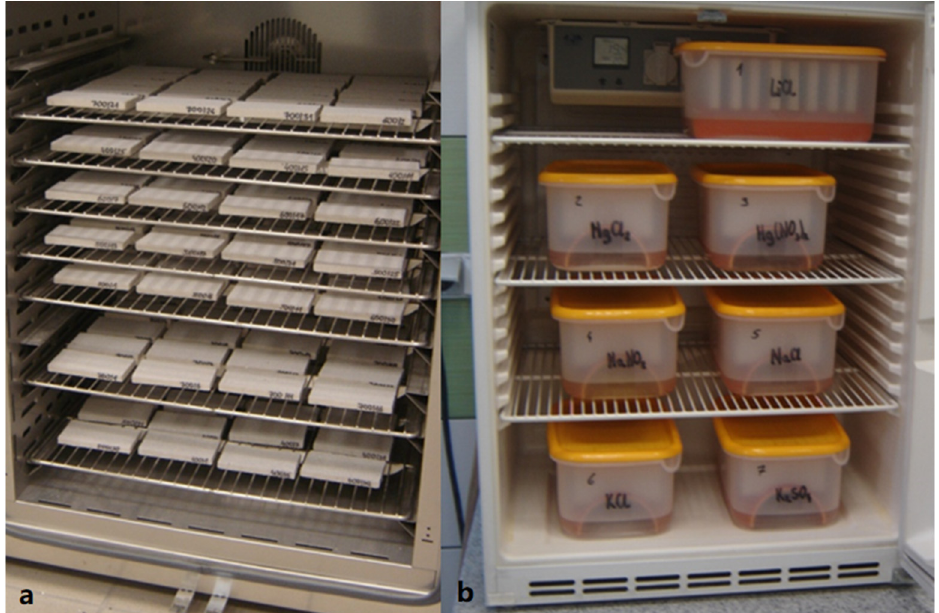
Figure 6. Samples dried to a constant mass, located in the dryer ( a ) and samples in closed containers placed inside the thermostatic chamber ( b ). Both photographs are from the authors’ collection.